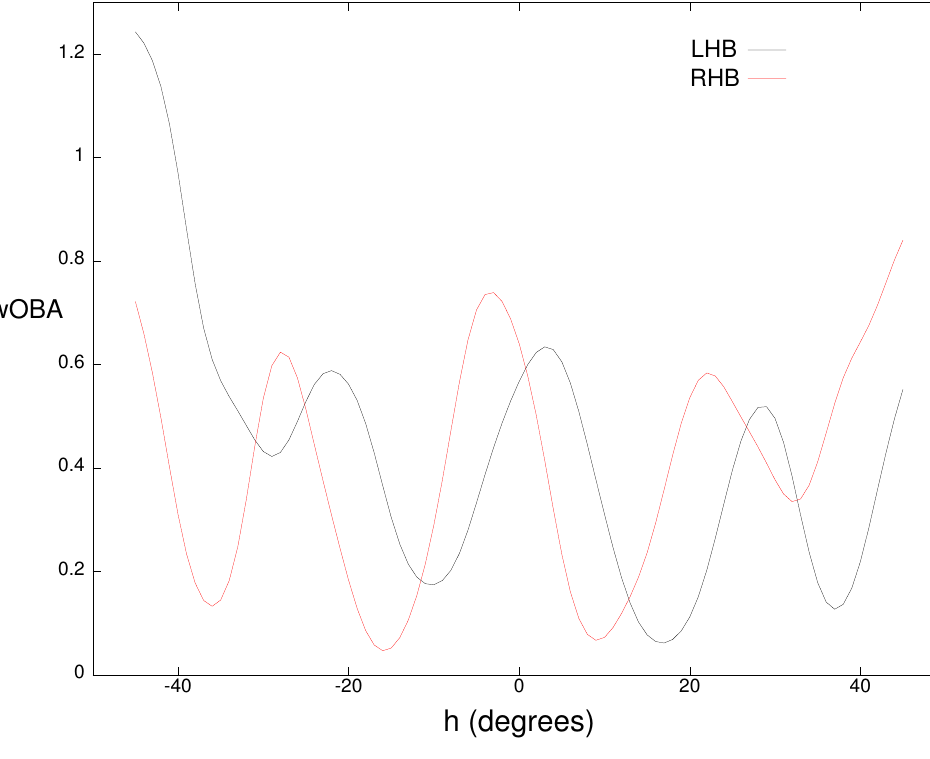
Figure 5. Weighted on base average (wOBA) for a batted ball with a vertical angle v of − 5 ◦ and a speed s of 93 miles per hour for left-handed batters (LHB) and right-handed batters